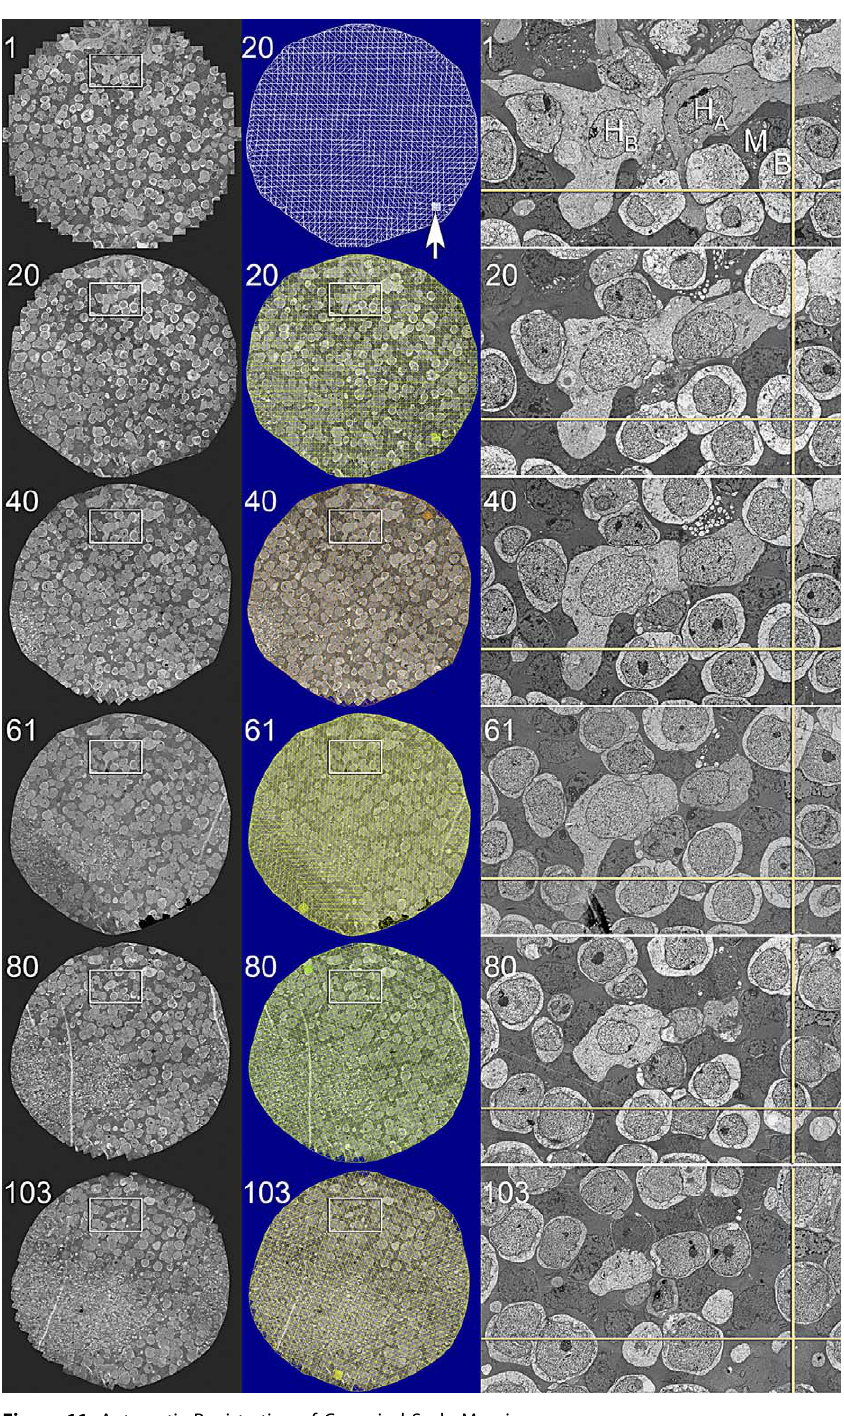
Figure 11. Automatic Registration of Canonical Scale Mosaics The left two columns are six 1,000 þ tile mosaics from a series of over 120 horizontal plane 70-nm sections of the rabbit inner nuclear layer (sections 1, 20, 40, 61, 80, 103) spanning over 9 l m. Each mosaics is 250 l m wide. The middle column shows mosaics 20, 40, 61, 80, 103 with a colored overlay of the tile adjustment mesh (the true subtile mesh is much finer). The high contrast version of the mosaic 20 mesh shows that the bounding and bisecting lines only slight deviations from linearity due to slice-to-slice distortions. However, these do not accumulate. The arrow indicates a patch of the true mesh density. The right column (53 l m wide) is a magnified region of each slice showing the excellent cell-to-cell and subcellular alignment achieved by purely automatic image registration with ir-tools .